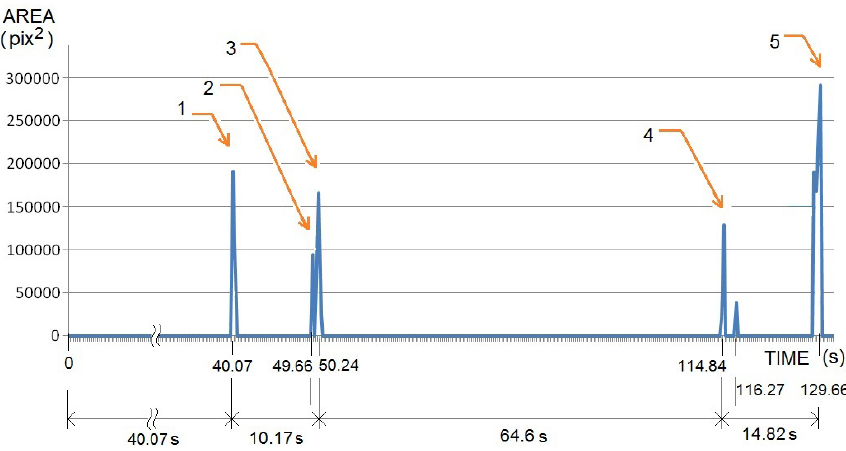
Fig. 9. Morphology of the lights observed. The horizontal time axis shown represents seconds as measured from the start of the accelerometer records. The areas represent the colors and intensity of the flashes observed, as explained in the text and shown in Fig. 8.